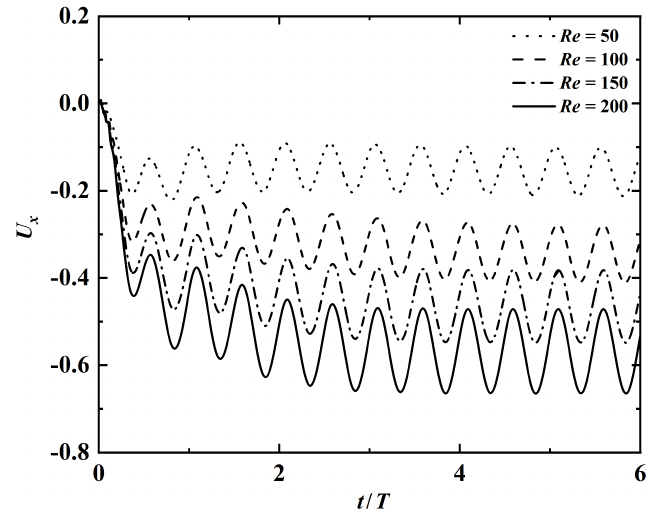
Figure 12. Time histories of the leading-edge’s horizontal velocity at different values of Re . The fixed parameters are: k = 4 π , A = 200.